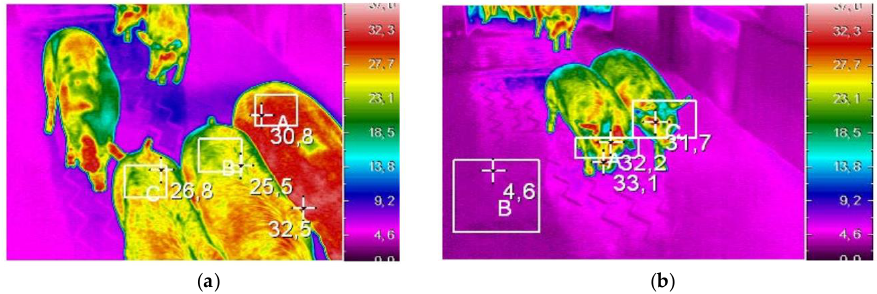
Figure 2. Examples of thermal images of the dorsal ( a ) and ocular ( b ) regions recorded during the unloading of Italian heavy pigs at the slaughterhouse after transport of approximately 30 min under commercial conditions. The white rectangles indicate the areas in which the maximum temperatures were